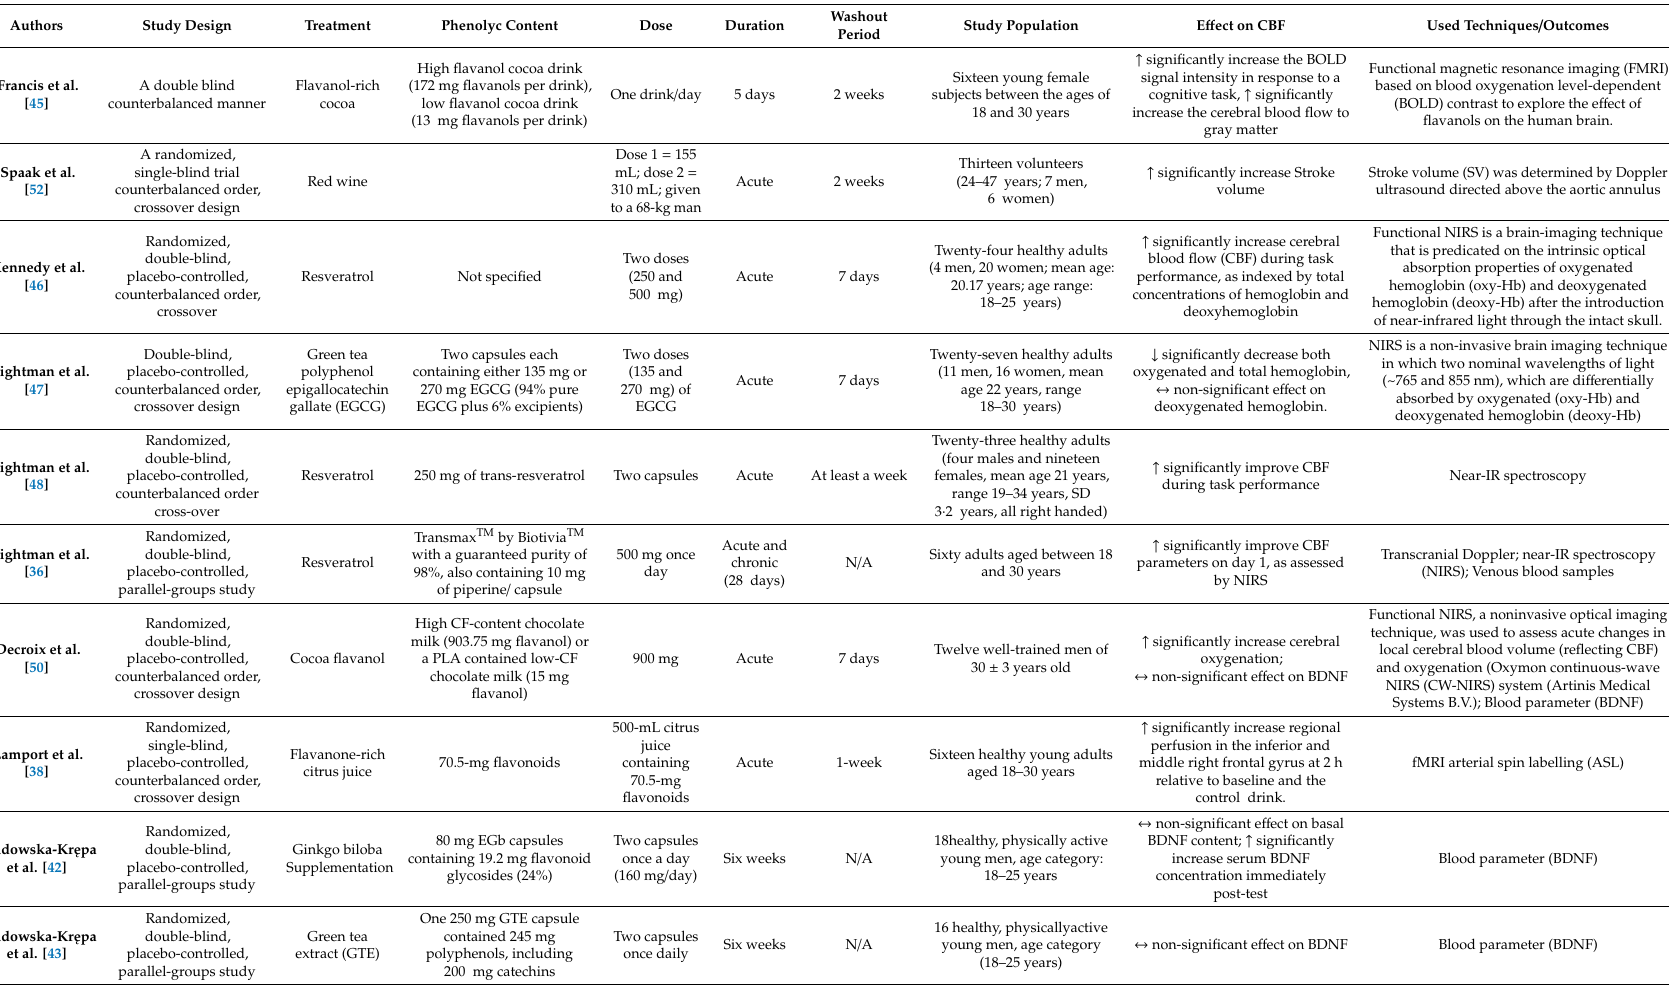
Table 2. E ff ect of (poly)phenol-rich supplementation on brain health measures in young- and middle-aged